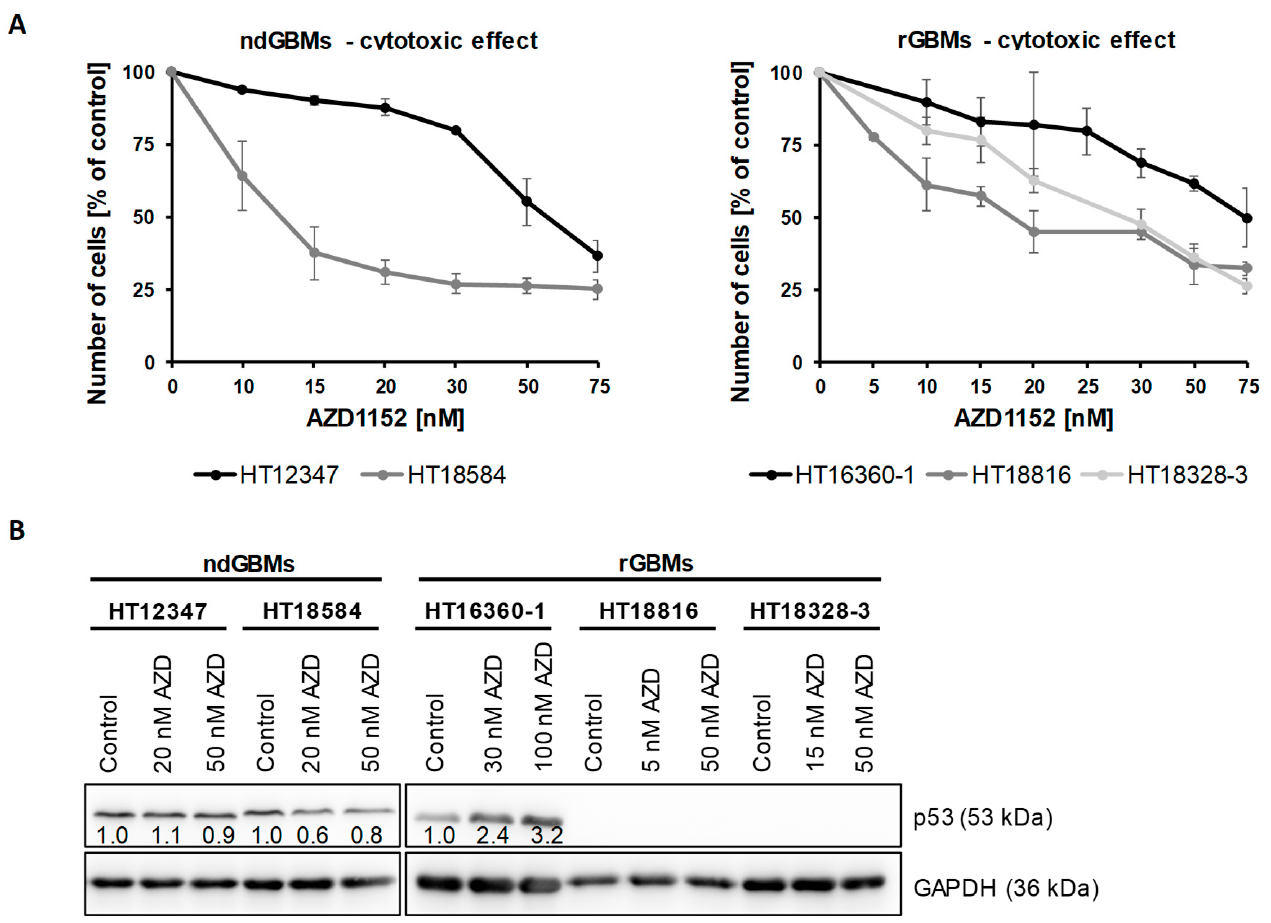
Figure 2. Sensitivity towards AZD1152. Treatment of primary glioblastoma cultures with increasing AZD1152 concentrations results in varying degrees of cell viability and different p53 responses. ( A ) Cells were treated with AZD1152 (5–75 nM) for 72 h and subsequently their viability was determined by flow cytometry using propidium iodide. Data represent mean ± SD (N = 9). ( B ) p53 expression was detected by immunoblotting upon treatment with different AZD1152 concentrations for 72 h, at which approximately 75% and 40% of cells survived, respectively (N = 2). Equal loading was confirmed using a GAPDH antibody. Band intensity of p53 was normalized to and compared to those of GAPDH and compared to control.